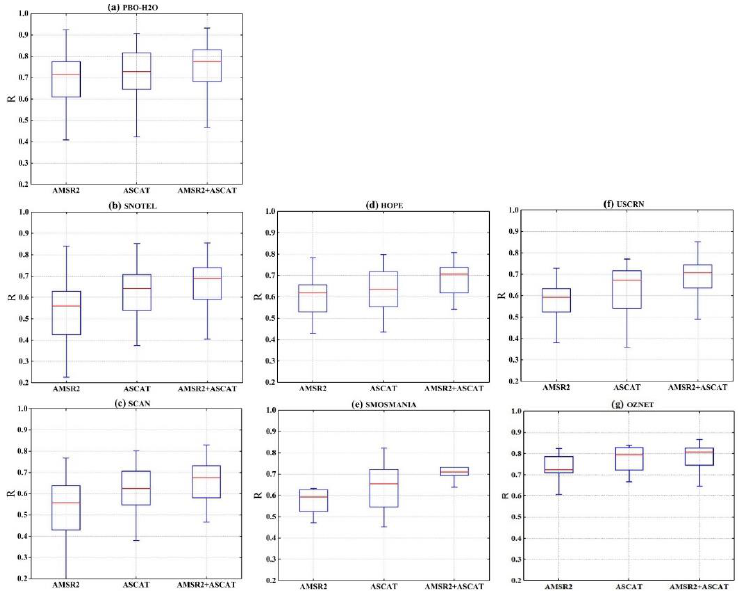
Figure 8. Box plots of correlation coefficients of AMSR2+ASCAT, AMSR2, and ASCAT SM datasets against the in-situ SM observations of different ISMN networks: ( a ) PBO-H2O; ( b ) SNOTEL; ( c ) SCAN; ( d ) HOPE; ( e ) SMOSMANIA; ( f ) USCRN; and ( g ) OZNET.